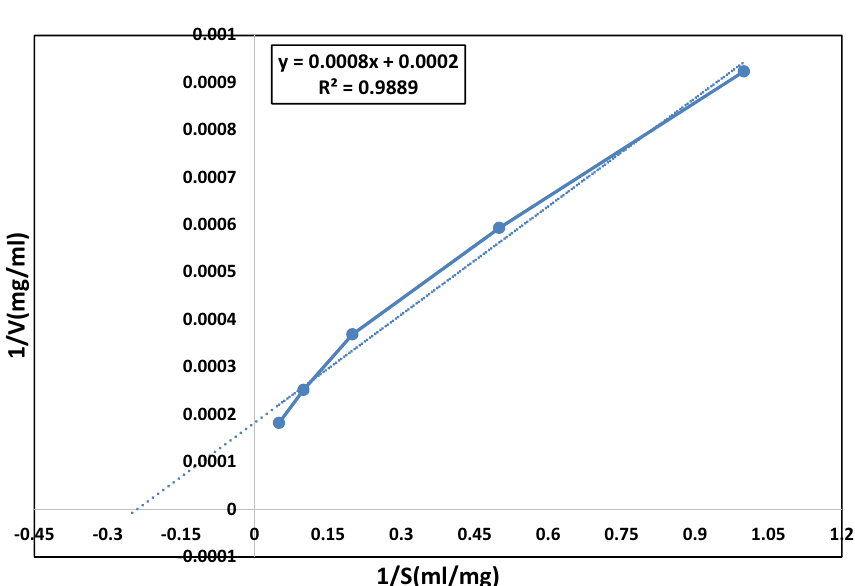
Figure 6. Lineweaver–Burk plot of xylanase enzyme from Paecilomyces